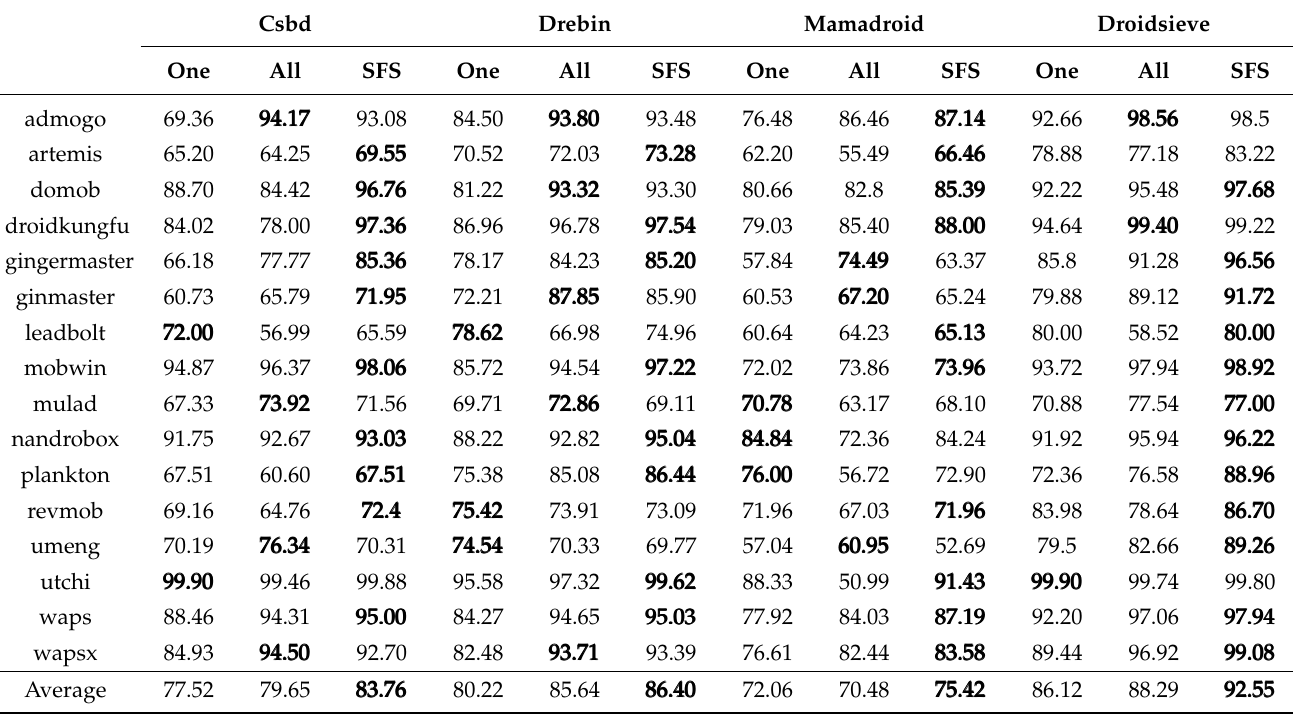
Table 8. The malwaredetection ability when using the outdated training data. The number in bolds shows the best